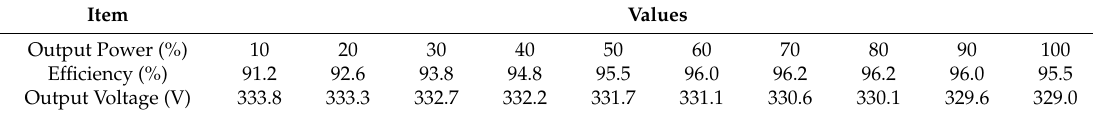
Figure 19. Dependency of the converter’s efficiency and output voltage on the output power (measurement). Table 3. Values of the efficiency and output voltage in dependency on the output power (Measurement). Item